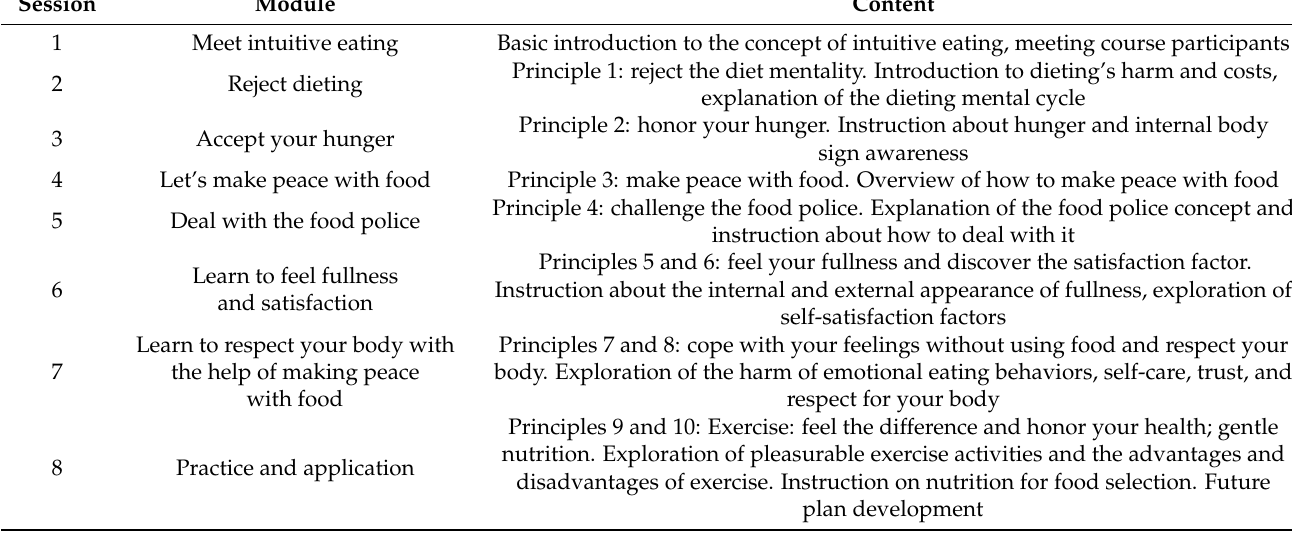
Table 1. Intuitive eating intervention modules and overview of their